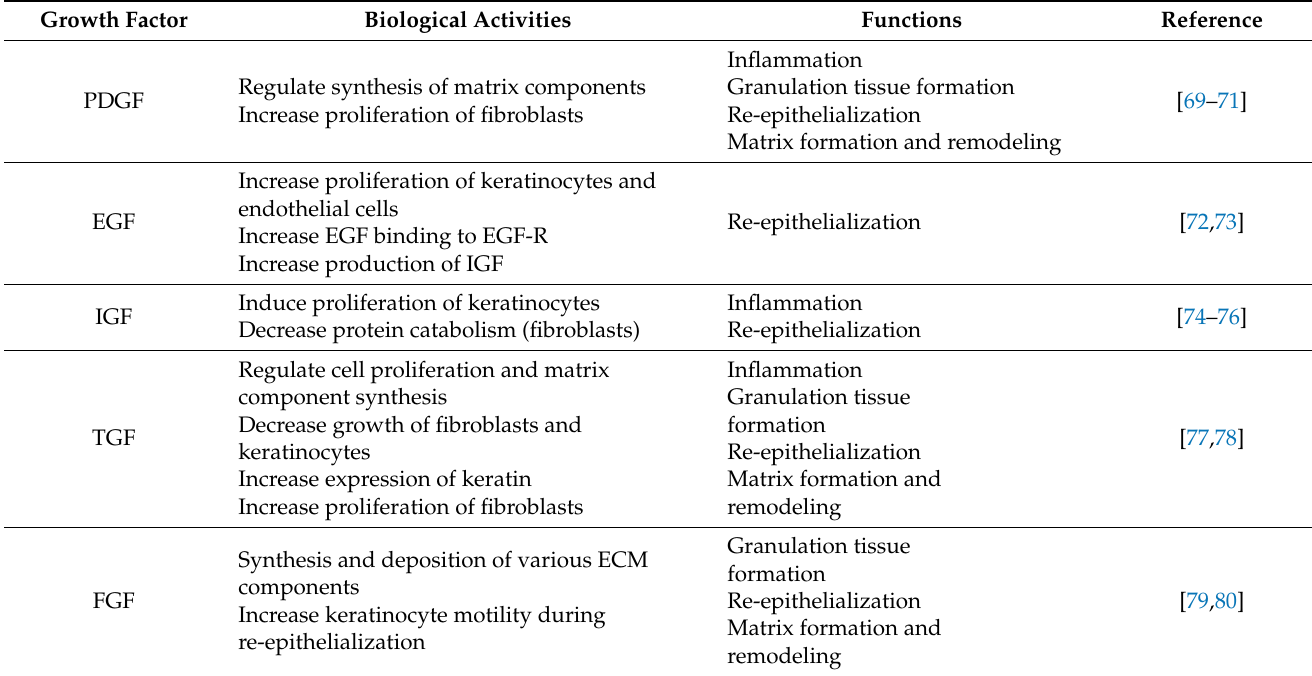
Table 2. Summary of biological properties and respective roles of the major growth factors that participate in wound